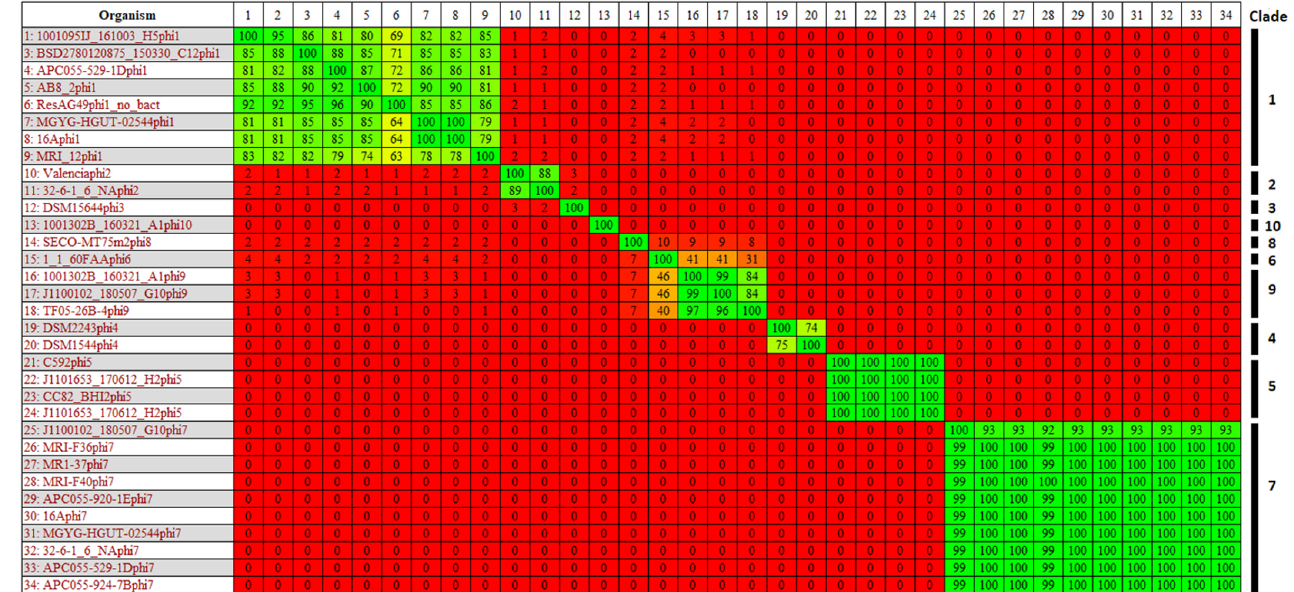
Figure 3. BLASTn heat map generated using Gegenees with accurate parameters—fragment length: 200 bp; step size: 100 bp; threshold: 0%. The map includes 33 identified prophage genomes of E. lenta , members of the ten different prophage clades are highlighted. Table 3. Putative insertion sites among clade 1 E. lenta prophages.